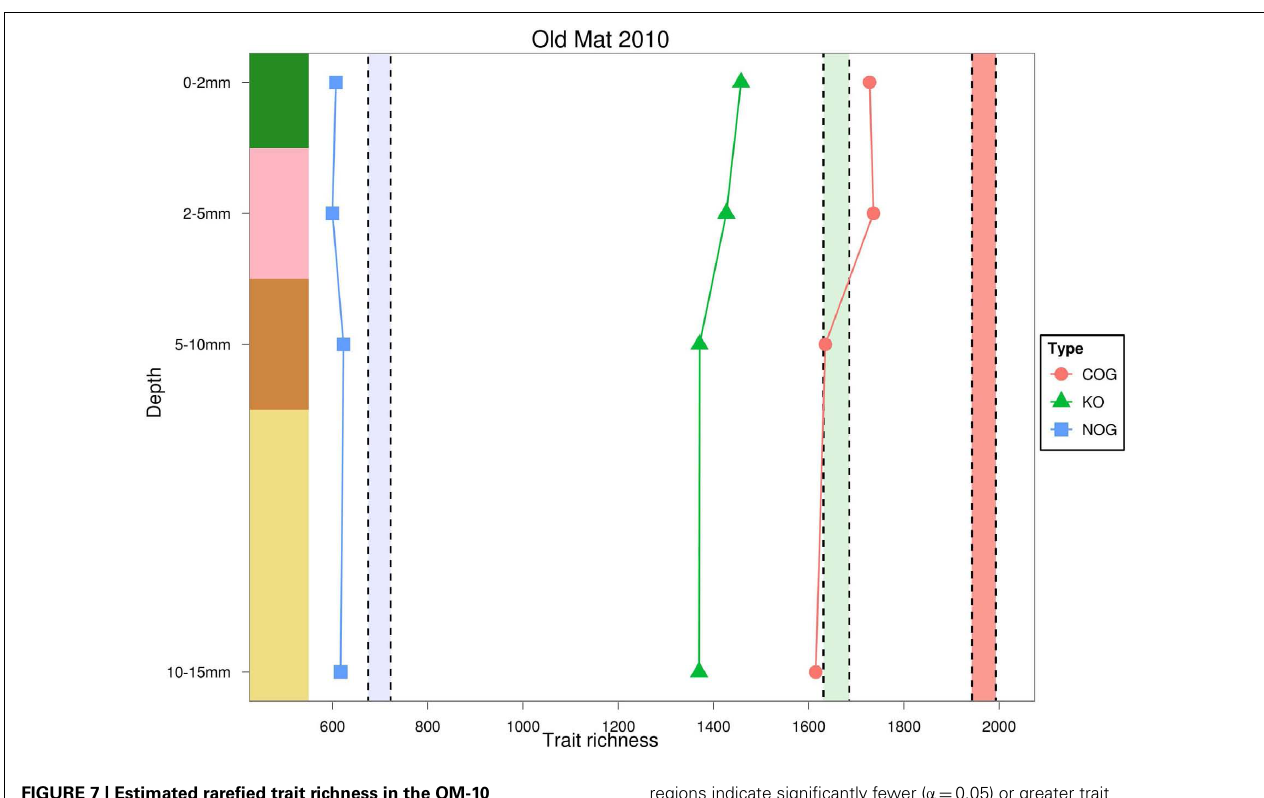
FIGURE 7 | Estimated rarefied trait richness in the OM-10 core using three different orthologous gene annotations. Values falling below or above their similarly colored shaded